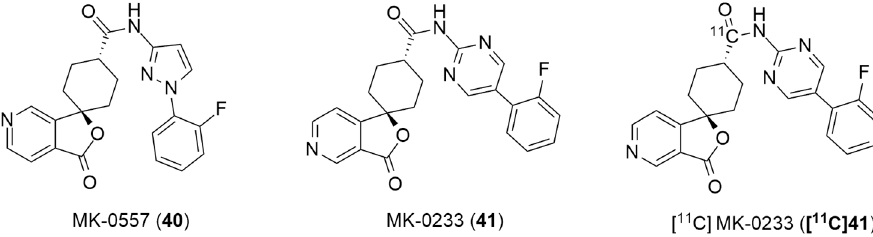
Figure 12. Structures of MK-0557 ( 40 ), MK-0233( 41 ) and PET ligand [ 11 C]MK-0233 ( [ 11 C]41 ).